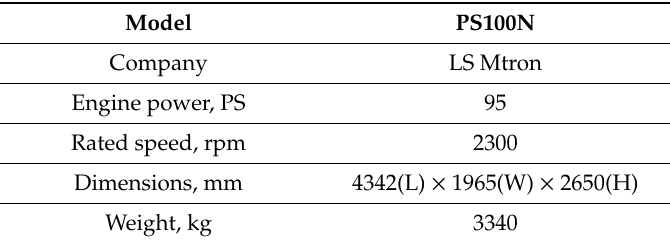
Figure 2. Structure of disk harrow assembly. Table 1. Specifications of farm tractor.